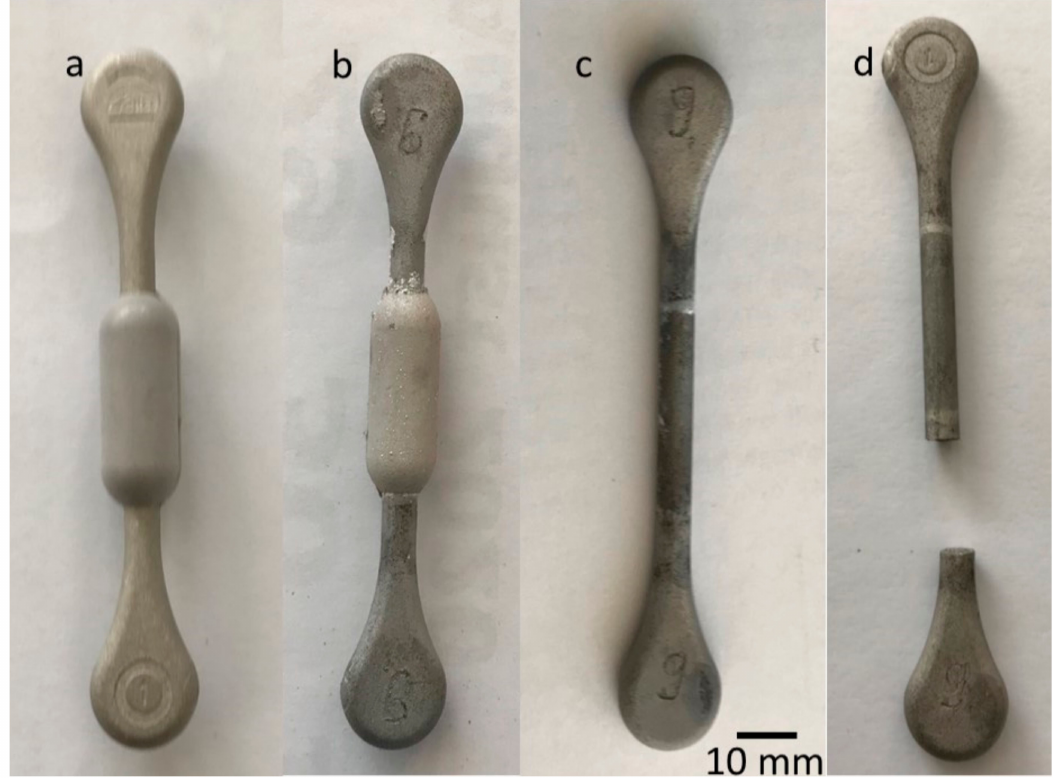
Figure 1. Dog-bone-shape tensile test samples of hybrid Ti64/Mg-0.6Ca after metal injection molding (MIM) production ( a ), sintering ( b ), corrosion ( c ) of Mg and tensile test ( d